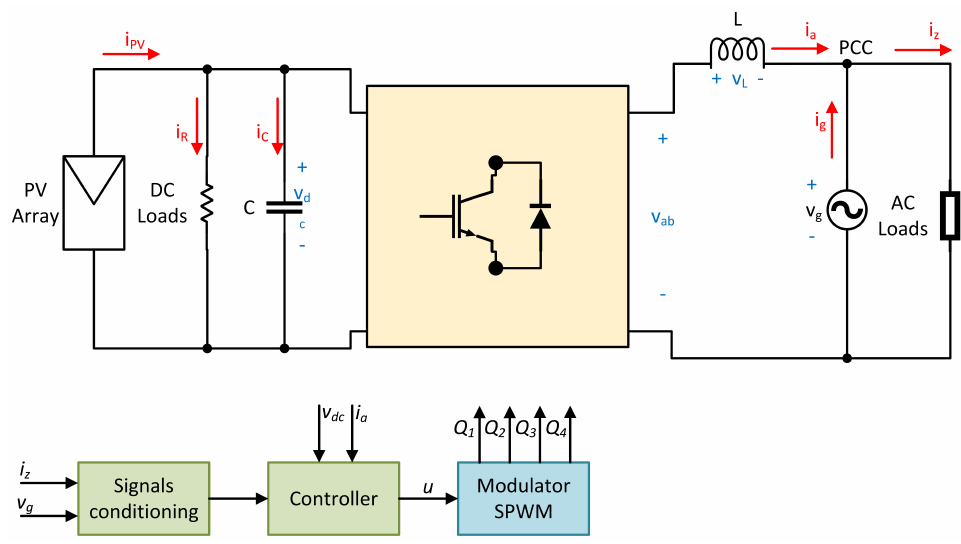
Figure 9. Converter and controller scheme.